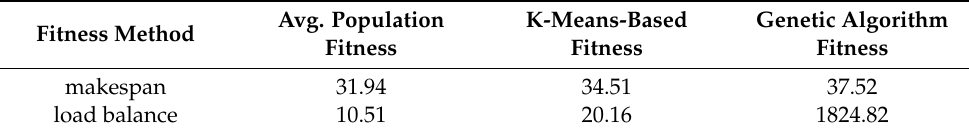
Figure 10. The evolution of the best chromosome’s fitness for a genetic algorithm that uses the load balance as the fitness function, with the average population fitness and k-means fitness for reference. Table 1. Fitness values depending on the aspect that was considered when computing the fitness (i.e., makespan or load